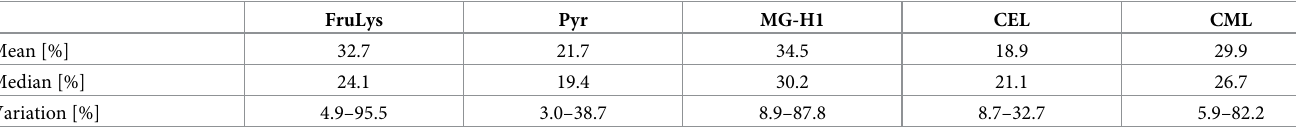
Table 3. Intraindividual variations of fasting salivary levels of selected (glycated) amino